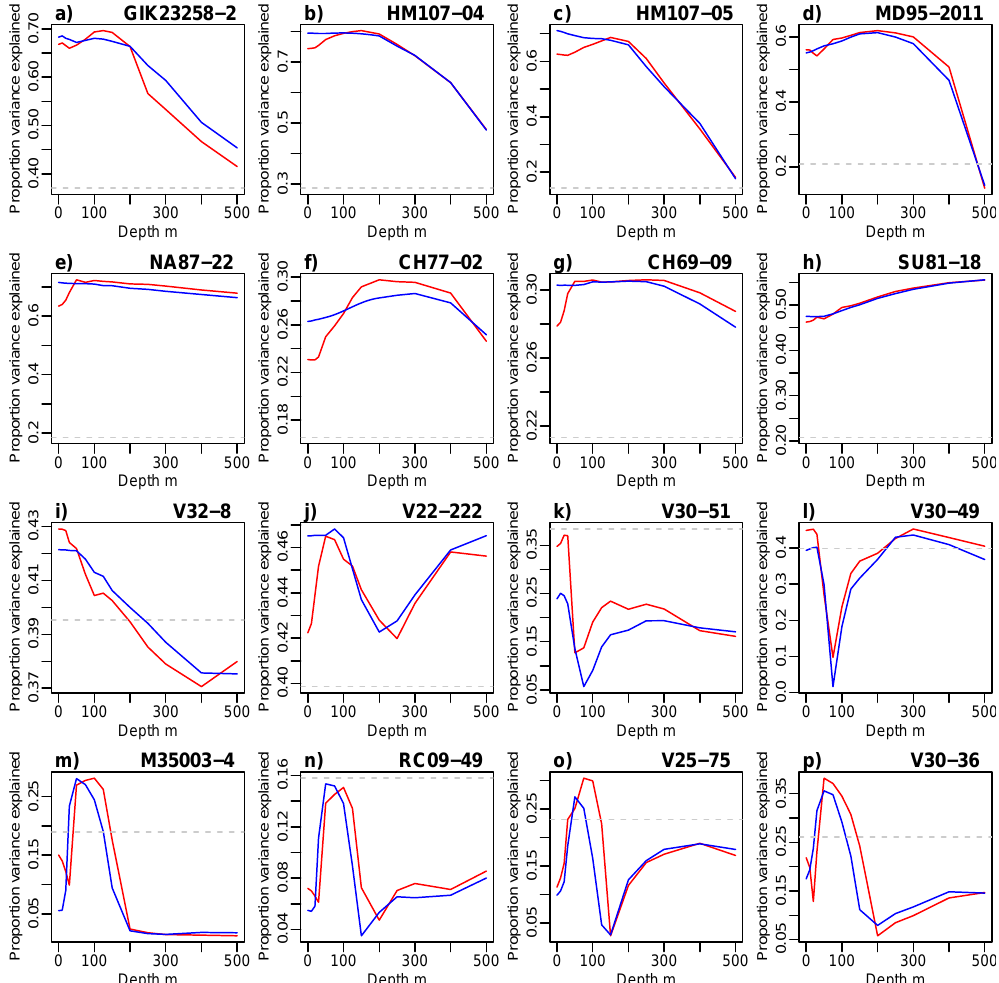
Fig. 5. The proportion of variance in the fossil data explained by reconstructions of warm (red) and cold (blue) season temperatures at different depths. The horizontal dashed grey line represents the 95% significance level, assessed by finding the proportion of variance explained by reconstructions of random environmental data. Note that the y-axis scale changes between plots and cannot be directly compared as the diversity is different at each